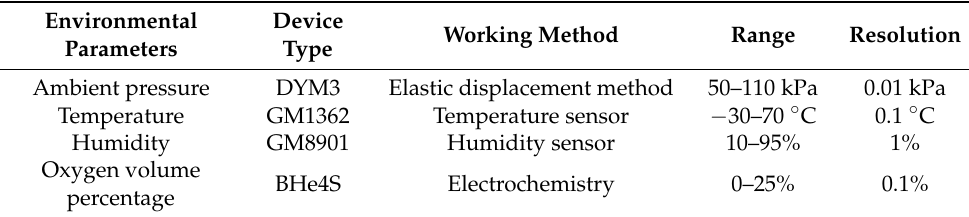
Table 2. Details of the devices used to measure environmental parameters.